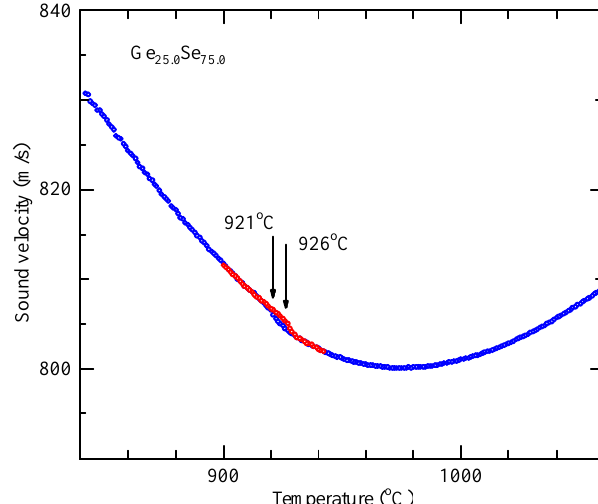
Fig. 3. Sound velocity in liquid Ge 25 Se 75 measured in the cooling process (blue symbols) is compared with those measured in the heating process (red symbols). Slight hysteresis can be seen in the temperature interval between 921 and 926 o C indicated by arrows.